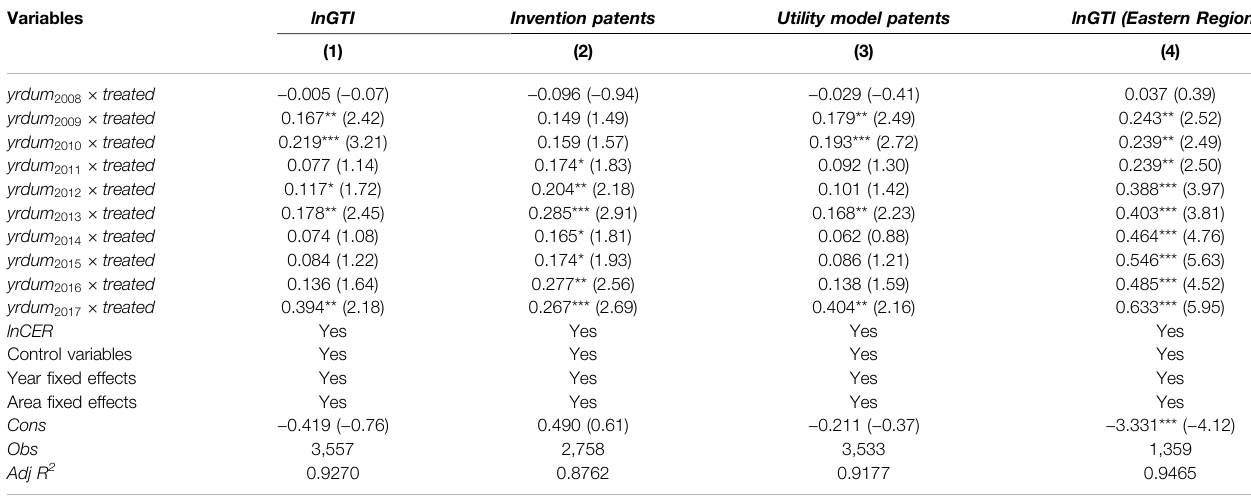
TABLE 7 | Heterogeneity analysis of the dynamic effect of SETP Variables